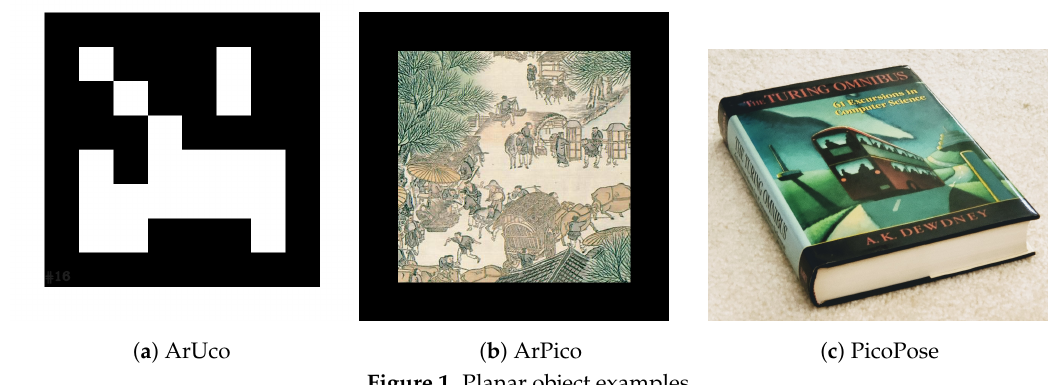
Figure 1. Planar object examples.